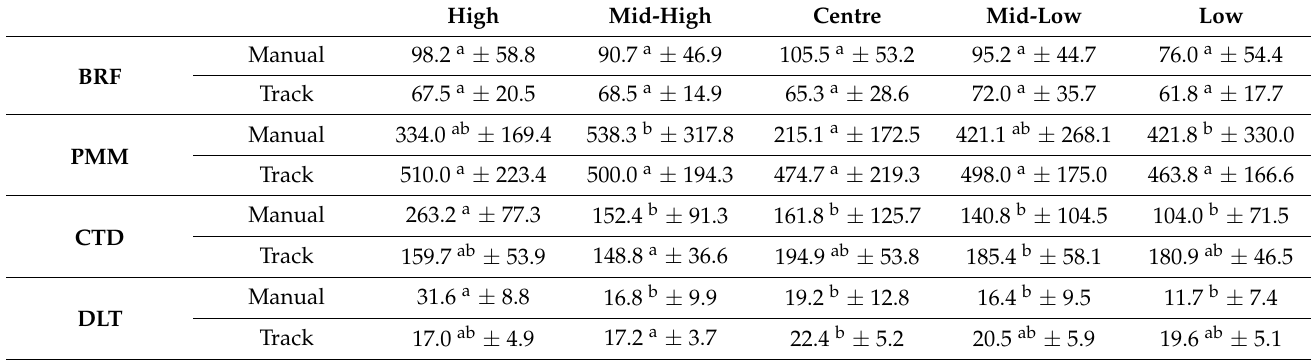
Table 5. Wall height analysis for track and manual spray for insecticides. Median application rate ± standard deviation is indicated for each vertical position. Comparisons are done between vertical positions by spray method. Significant differences are indicated by different lowercase letters. High Mid-High Centre Mid-Low Low